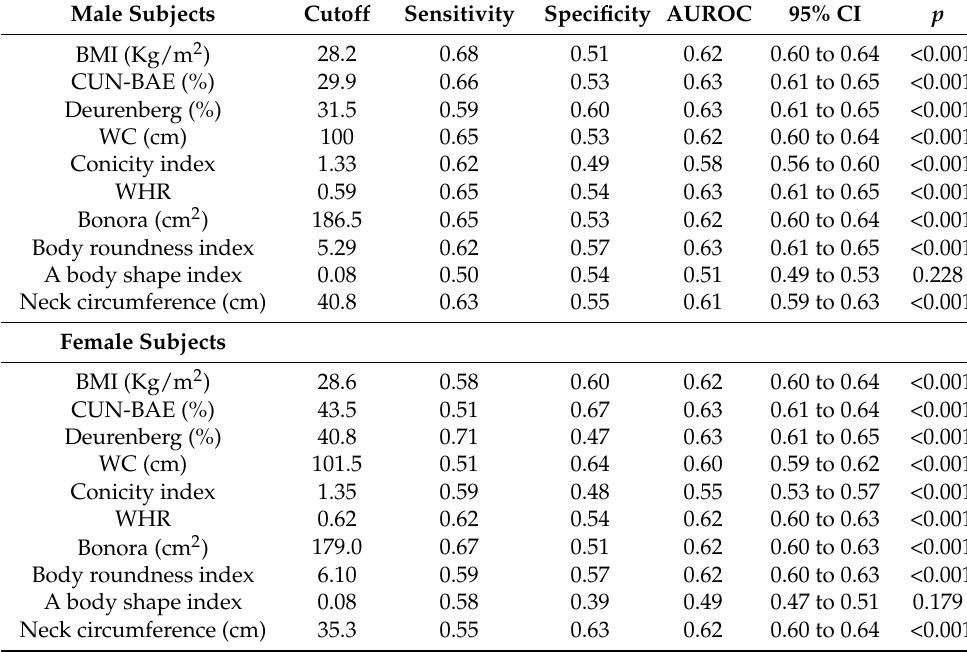
Table 4. Receiver Operating Characteristic curves and appropriate cutoff of anthropometric indices for predicting prediabetes according to sex